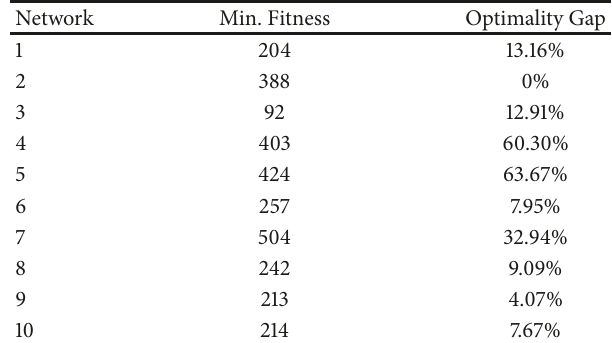
Table 6: MIP gaps of minimum objective values found. Network Min.